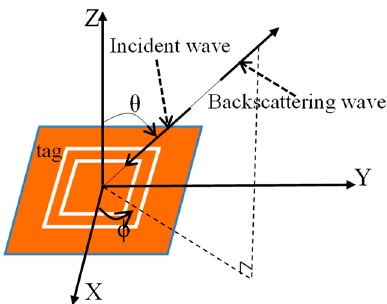
Figure 8. Schematic of incident angle of the signal θ relative to the vertical orientation, angle of horizontal rotation φ defined on the tag.